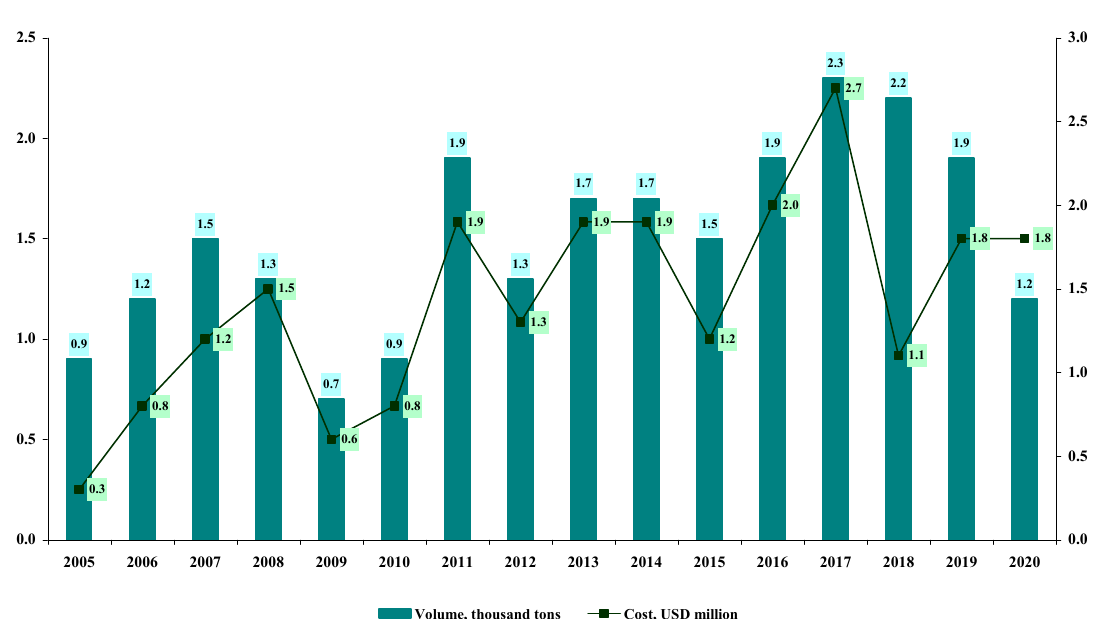
Figure 1. Dynamics of wheat seeds imports, USD without VAT. Source: State Statistics Service of Ukraine.